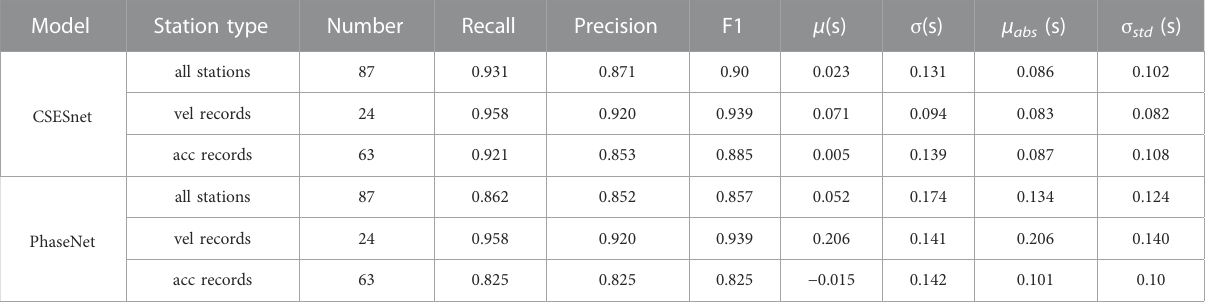
TABLE 4 Comparison of the performances of CSESnet and PhaseNet with Luxian M6.0 earthquake data.